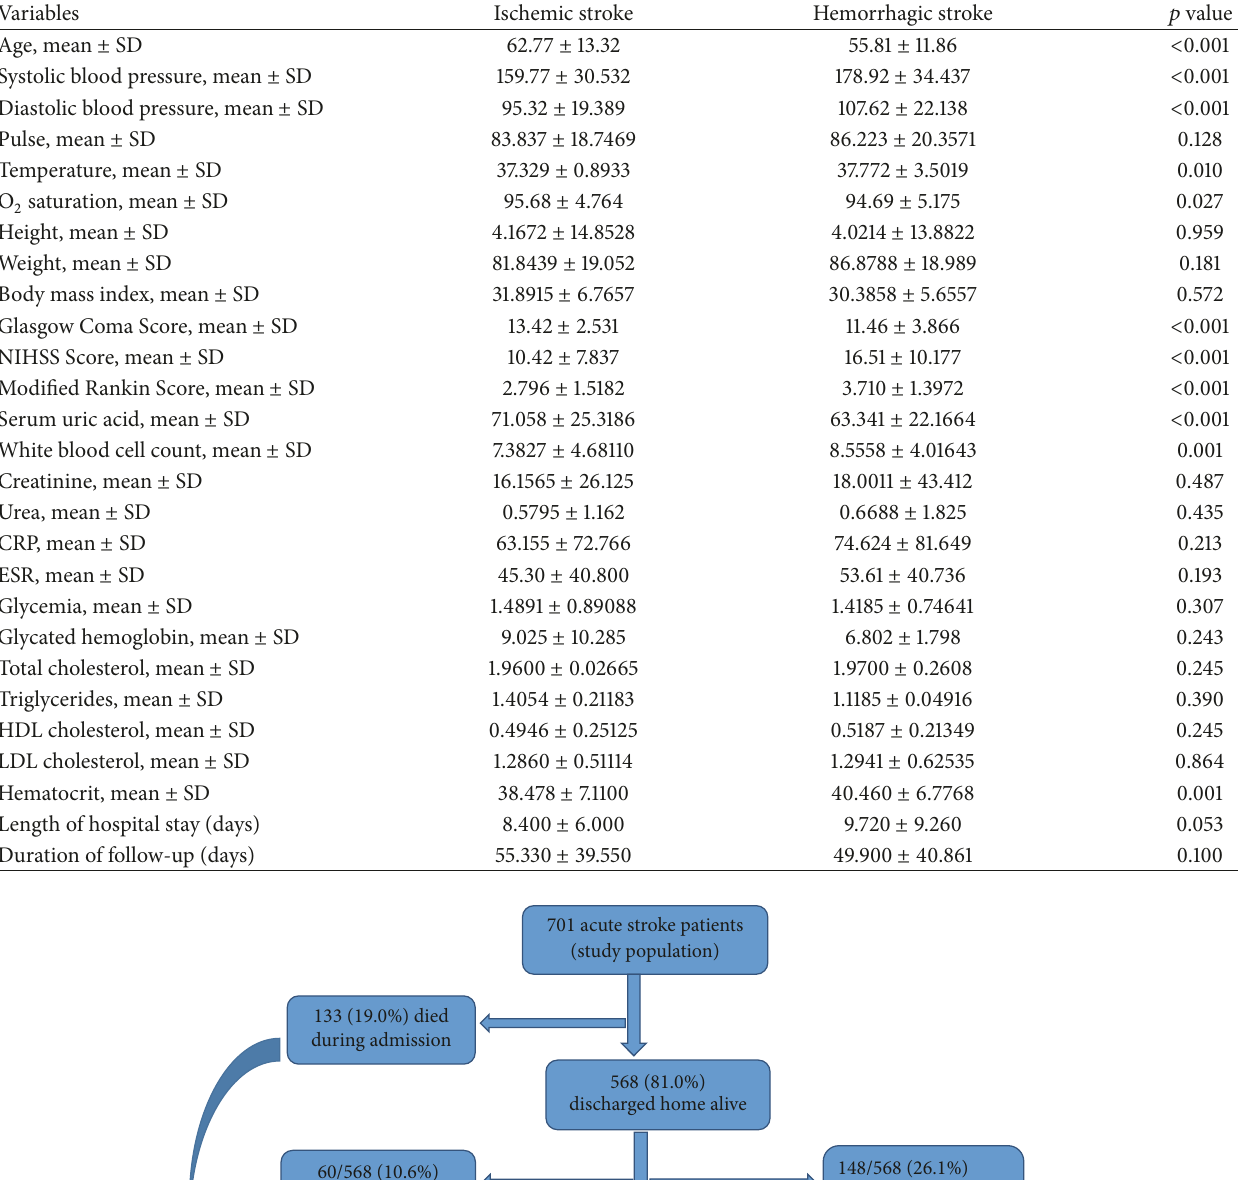
Table 2: Baseline clinical profile of acute stroke patients.